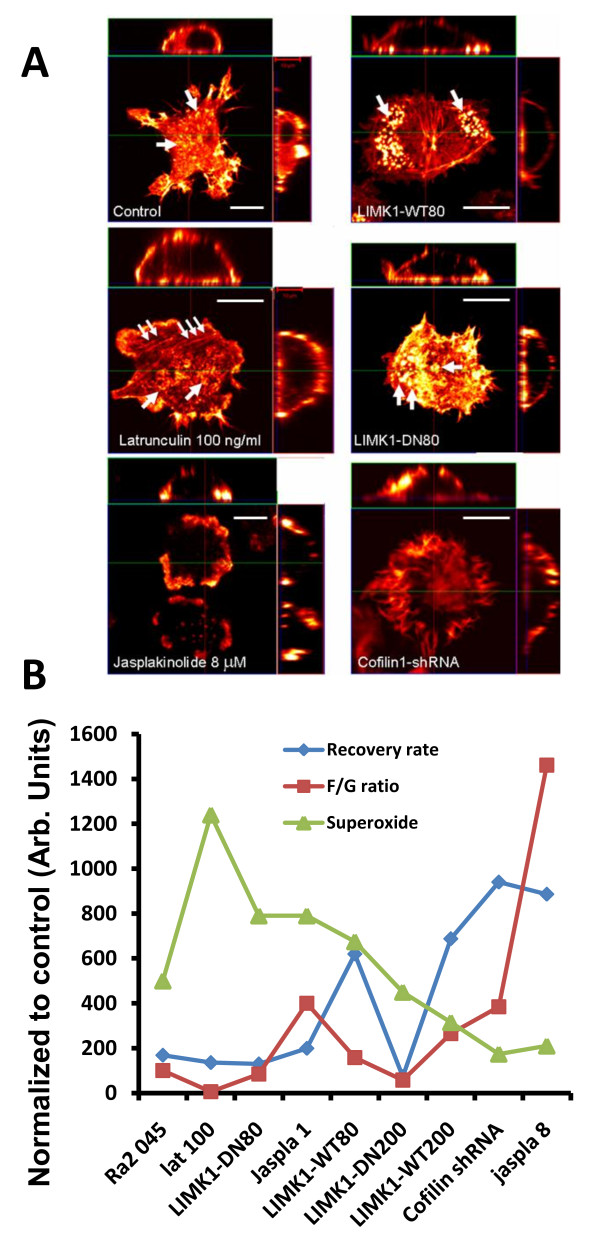
Changes in morphology and relative changes in superoxide production, F/G-actin ratio, and actin recovery half-time following different experimental perturbations of the actin cytoskeleton. A) Ra2 LIMK1-WT80, Ra2 LIMK1-DN80, Ra2 cofilin-shRNA1, and Ra2 wild type cells treated for five minutes with 100 ng/ml latrunculin or 8 μM jasplakinolide were paraformaldehyde fixed and stained with Alexa 568-conjugated phalloidin, and then Z-stacks (20-40 planes, ca. 0.25-0.75 μm section width) were acquired. In the case of 8 μM jasplakinolide treatment z-stacks were generated using β-actin-YFP fluorescence as jasplakinolide inhibits phalloidin binding to F-actin. Laser intensity and gain was adjusted to show detail and therefore does not reflect the levels of polymerized actin between cell lines. The images shown represent a XY-view of the most ventral z-plane of the cell (center) while a XZ projection is shown at the top, and a ZY projection on the side. B) For each parameter (superoxide production, F/G-actin ratio, and actin recovery half-time) absolute values derived from experiments above with PMA-stimulated cells were normalized to that of Ra2 045 control cells and depicted on the Y-axis in arbitrary units.